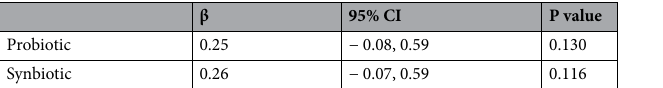
Table 4. Change in infant length for age (LAZ) from discharge to study completion in Probiotic and Synbiotic Groups vs, placebo after adjustment for age during discharge from hospital, sex, LAZ during discharge from hospital.